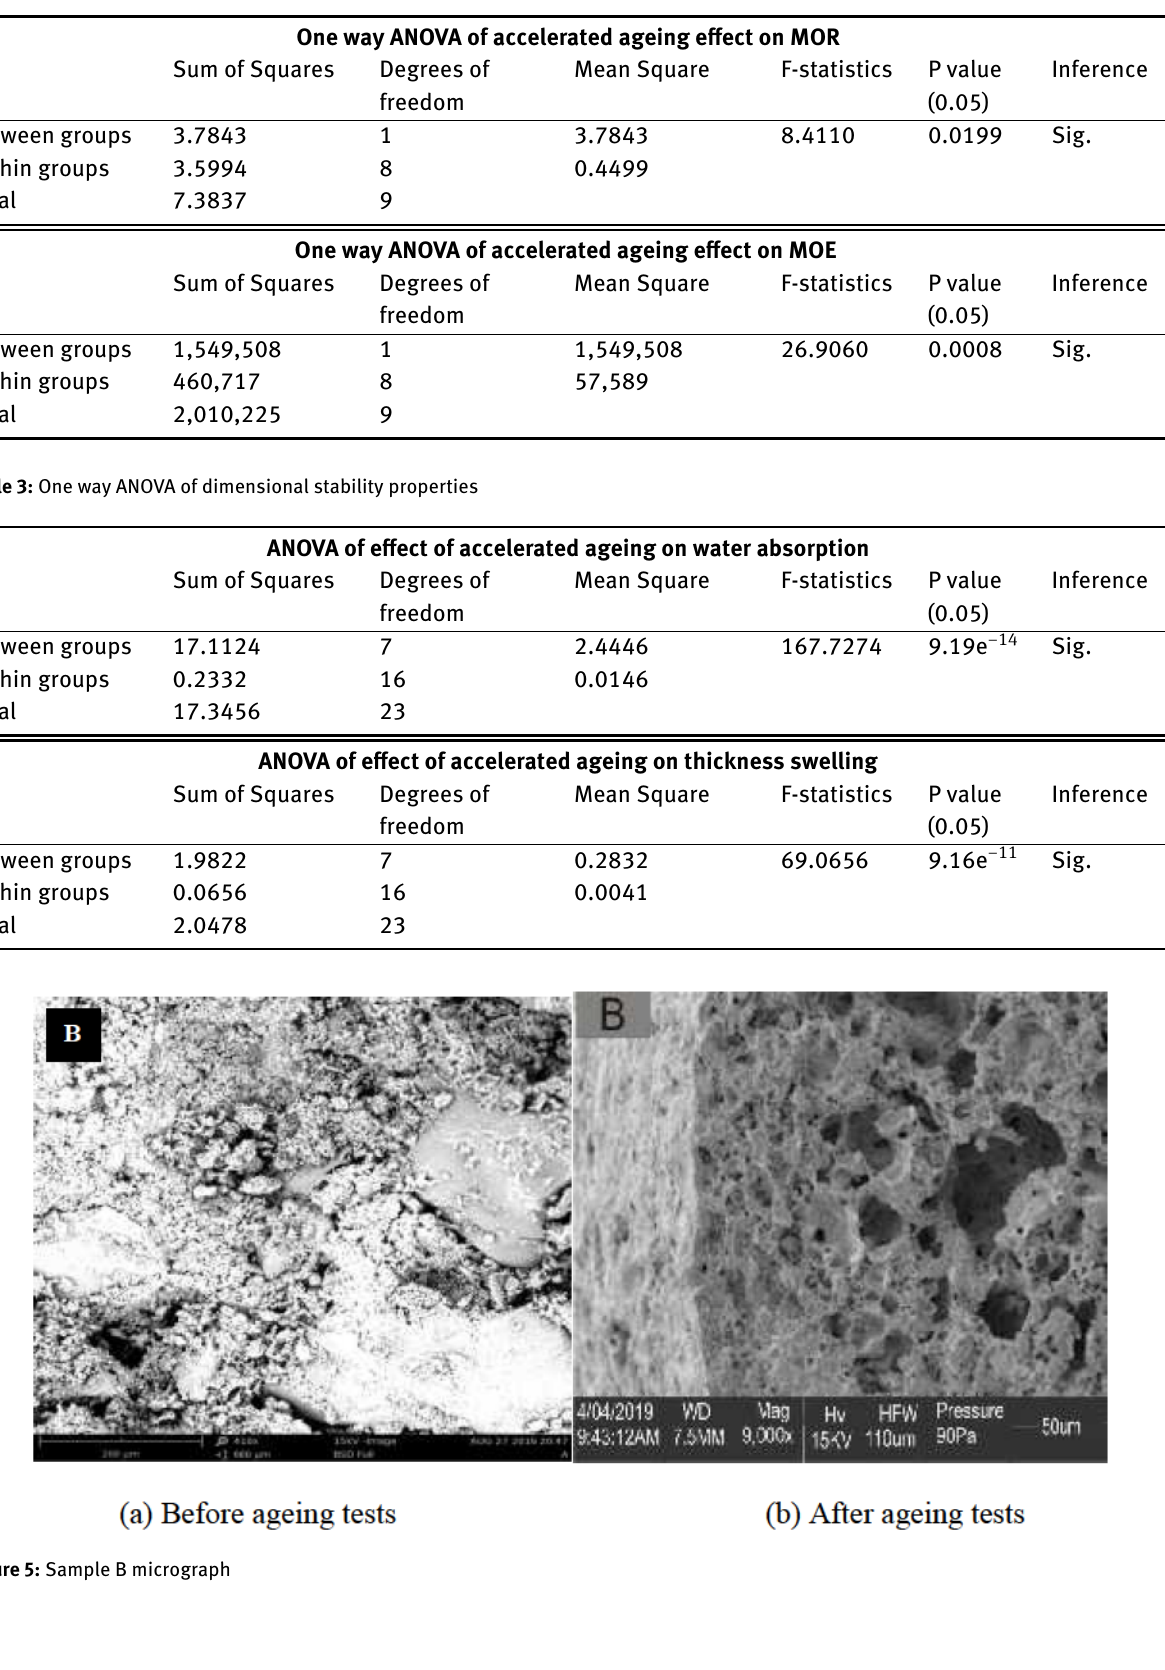
Table 2: One way ANOVA of mechanical properties